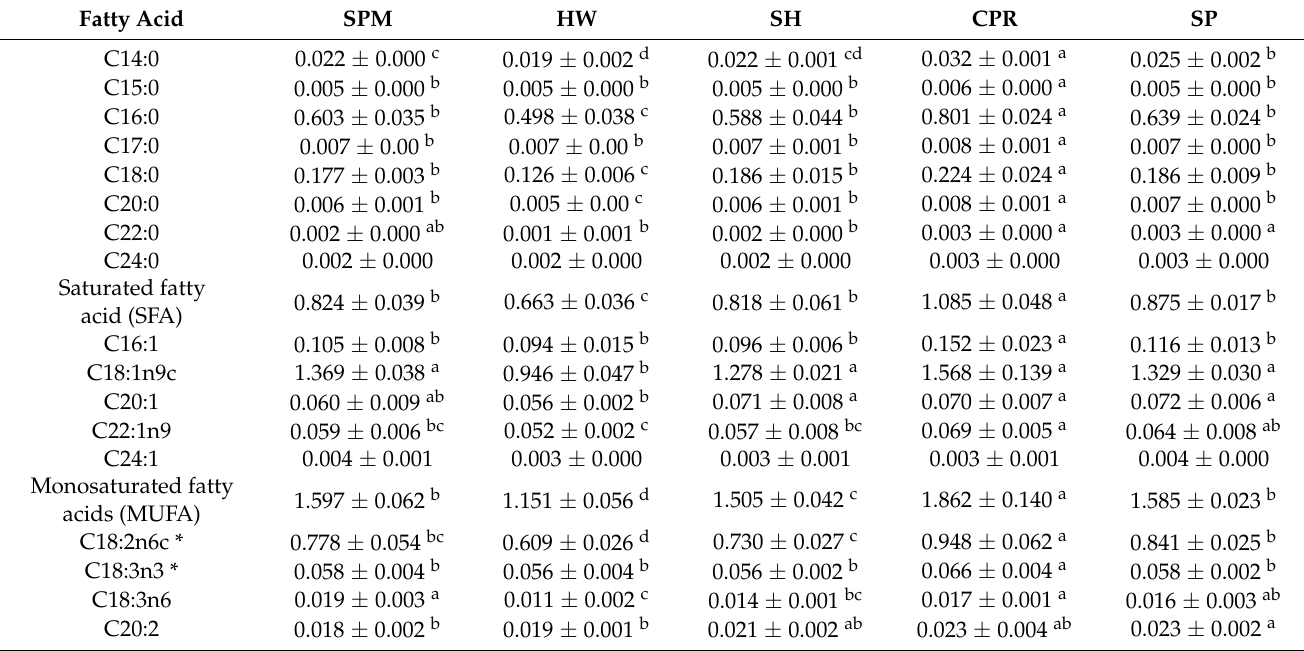
Table 8. Fatty acid content in five species of common carp (fresh flesh weight, g/100